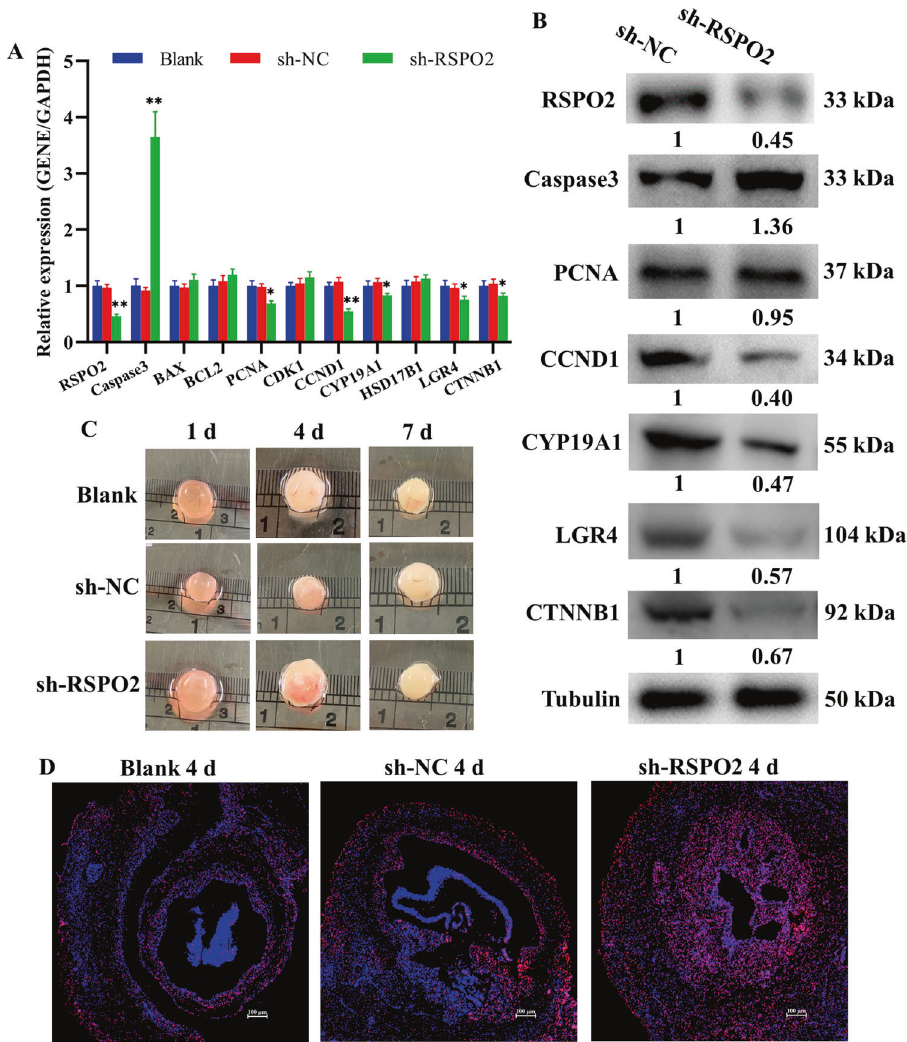
Fig. 5 RSPO2 knockdown blocked the development of porcine follicles. A, B The mRNA ( A ) and protein ( B ) expression levels of RSPO2 , Caspase3 , PCNA , CCND1 , CYP19A1 , LGR4 , and CTNNB1 in porcine follicle with RSPO2 inhibition. The numbers below bands were folds of band intensities relative to control. The band intensities were measured by ImageJ and normalized to Tubulin. C The photos of porcine follicles cultured in vitro after transfected with sh- RSPO2 on fi rst, fourth, and seventh day. D The apoptosis of follicular GCs was detected by TUNEL after transfected with sh- RSPO2 at the fourth day. * P < 0.05, ** P <